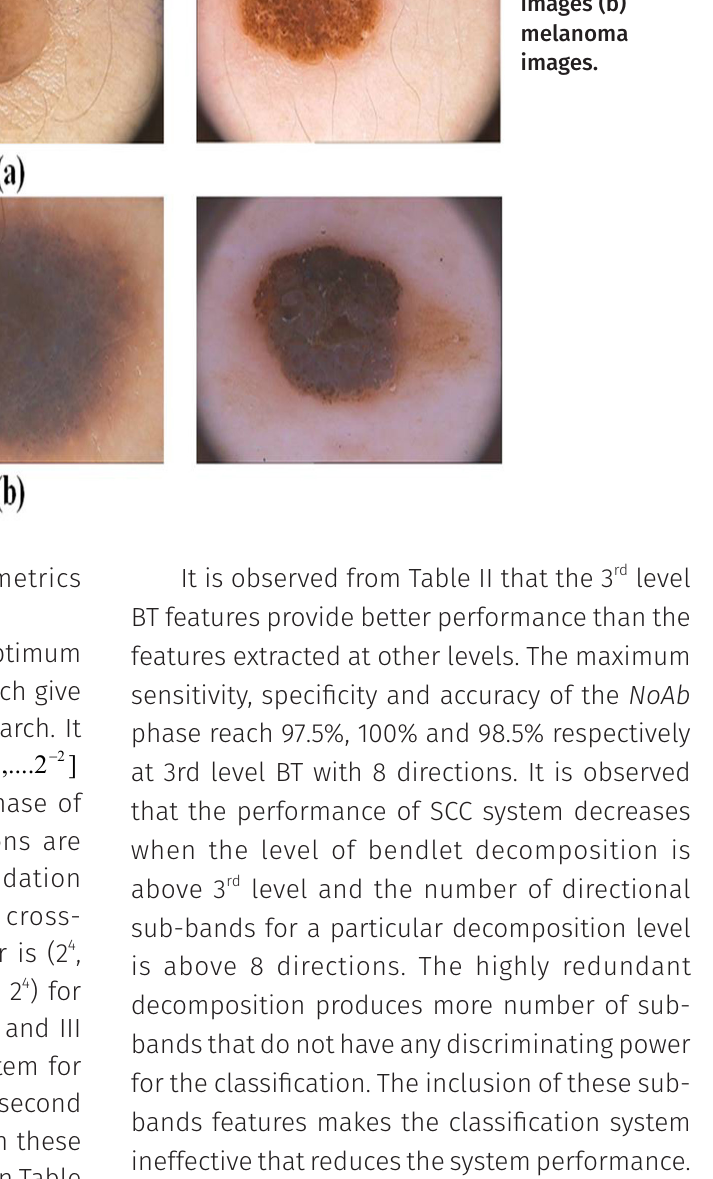
Figure 3. Sample images in the PH2 database (a) Normal images (b) melanoma